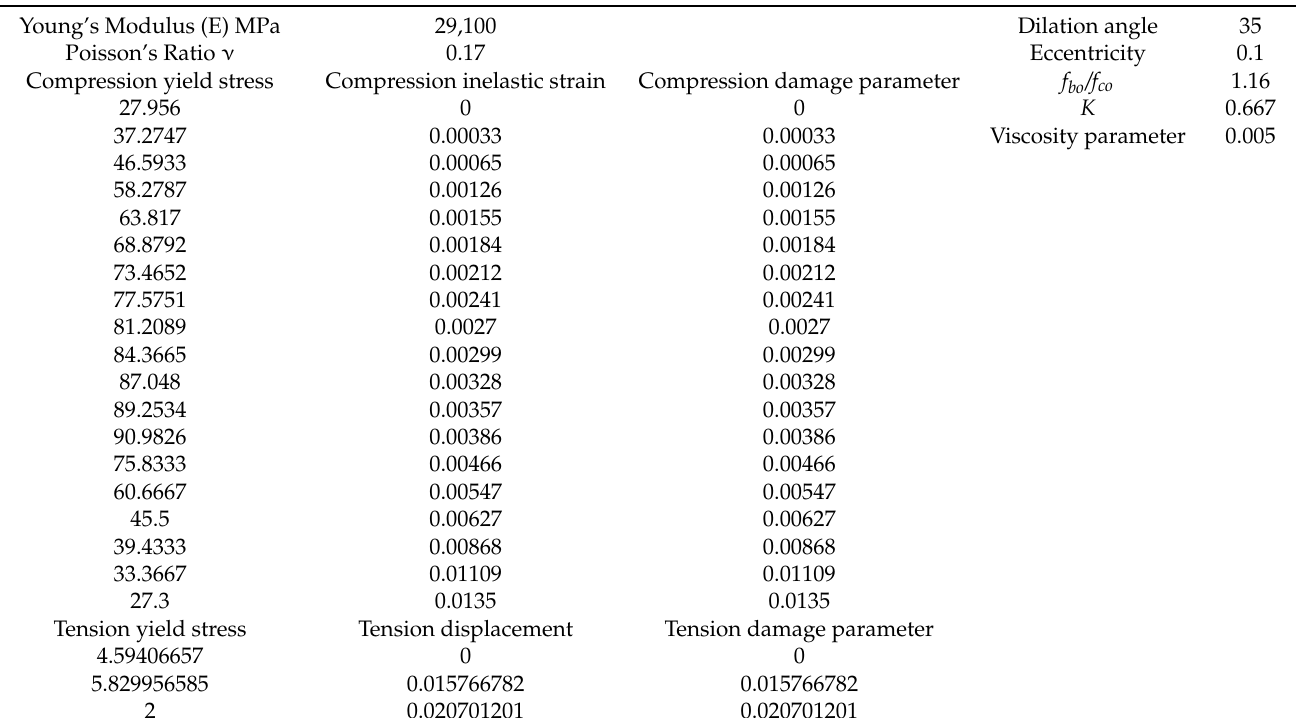
Table 9. CDP model for mortar cement ( f c (cid:48) = 90